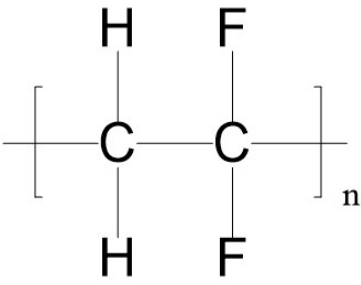
Polymers 2023 , 15 , x FOR PEER REVIEW Figure 1. The repeating unit of PVDF. Figure 1. The repeating unit of PVDF.